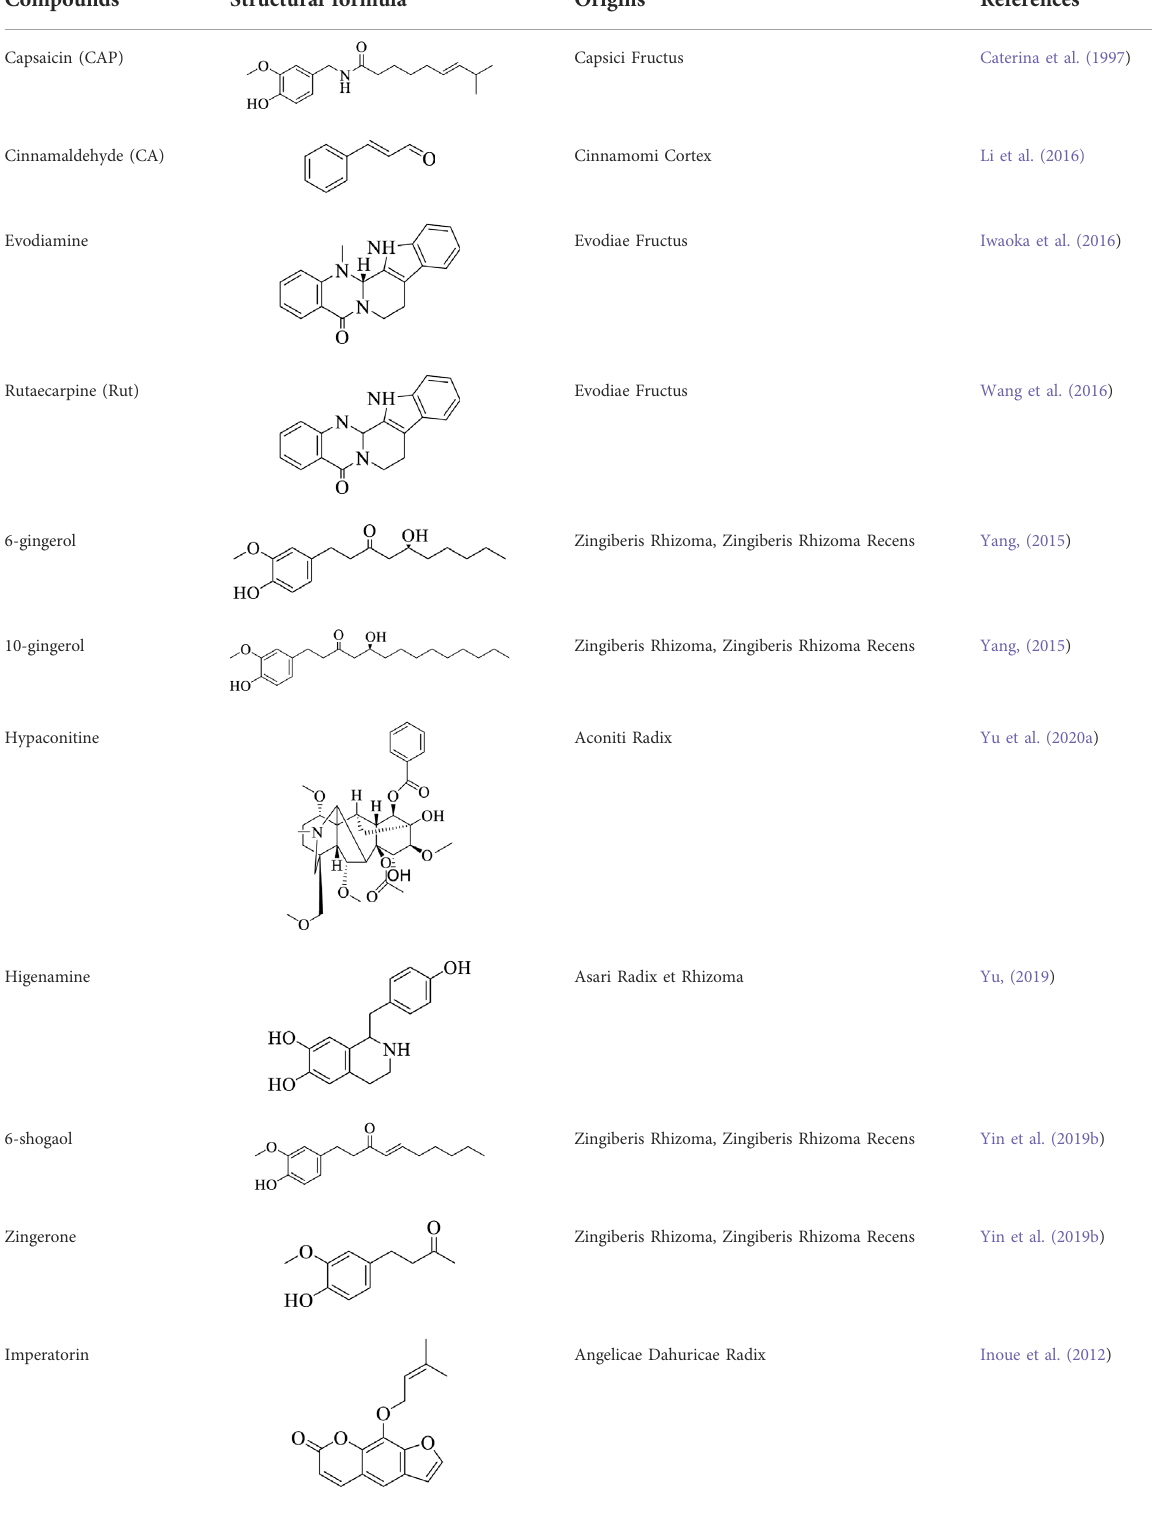
TABLE 3 List of compounds from Chinese herbal medicine that can affect TRP